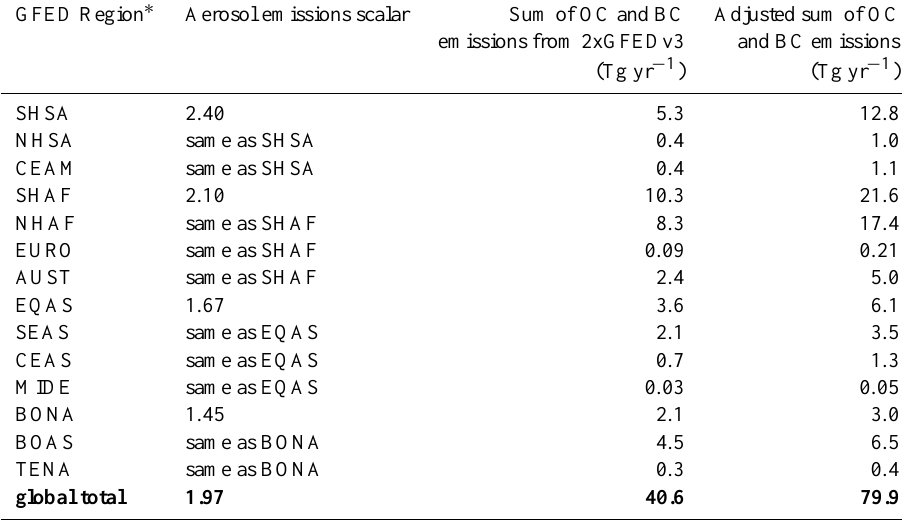
Table 2. Global BC and OC scalars and emissions from satellite-based